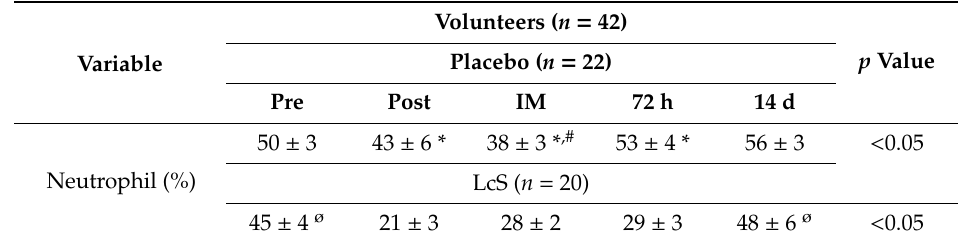
Table 2. Percentage of neutrophil infiltration on nasal mucosa of the study volunteers separated into groups LcS and placebo. All data are presented in mean and standard deviation and were analyzed by Student’s t-test. The level of significance was 5% ( p <